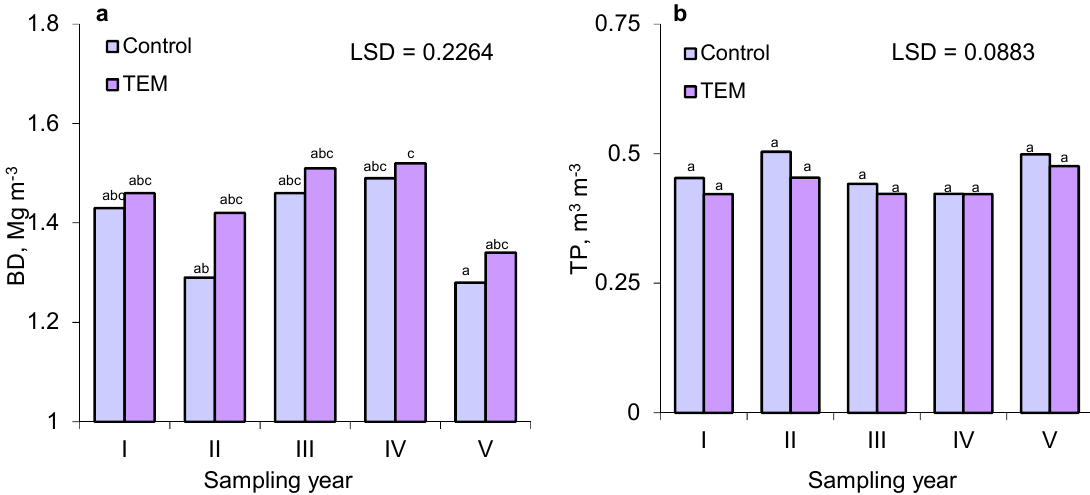
Figure 4. The annual mean values of soil bulk density (BD) ( a ) and total porosity (TP) ( b ) during the five-year study. Notes: Control: soil without EM-A ( n = 150), TEM: soil with EM-A application ( n = 150), I–V: study year. Each letter (a, ab, abc, and c) means a significant di ff erence (Control or TEM × study year) according to Tukey’s lowest significant di ff erence